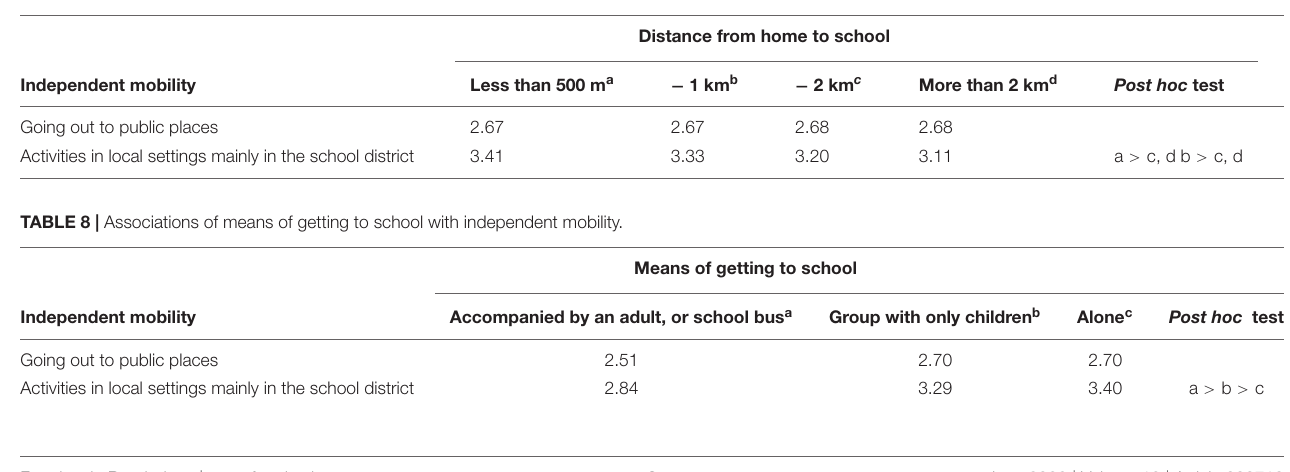
TABLE 7 | Associations of distance from home to school with independent mobility.